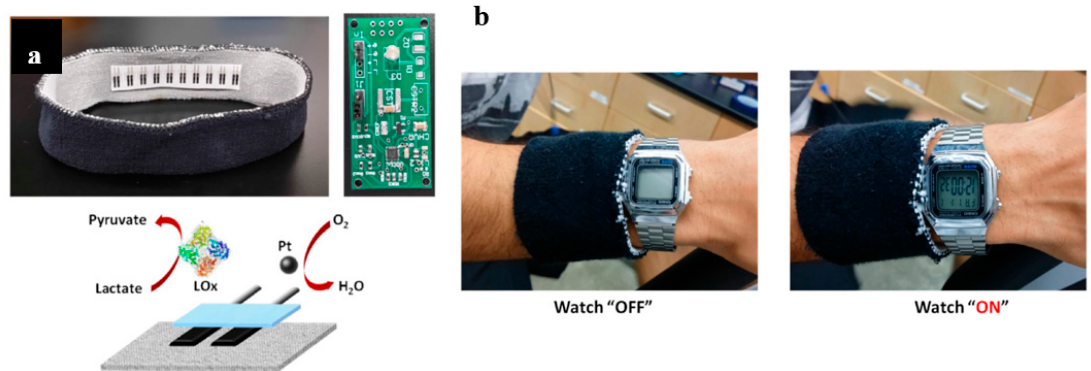
Figure 32. ( a ) The wristband biofuel cell, its DC/DC converter and illustration of the reaction taking place at the two electrodes. ( b ) wristwatch powered by human sweat. Adapted with permission from [150]. Copyright 2016 WILEY-VCH Verlag GmbH & Co. KGaA, Weinheim. To achieve good performances while being biocompatible, electrode materials are determined.